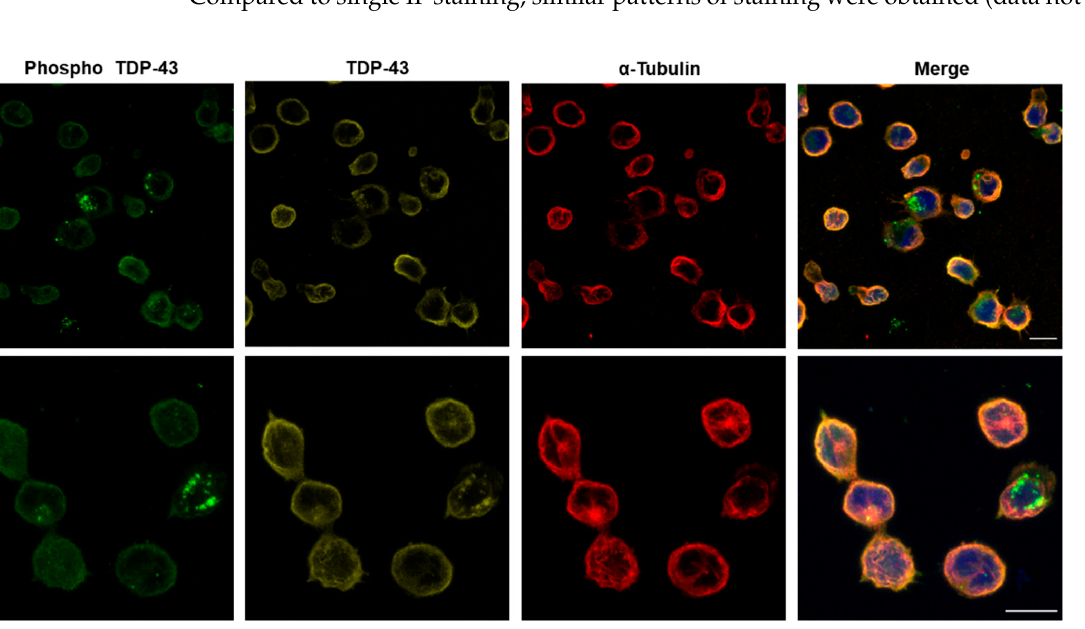
TEM. Figure S2. Electrophoretic mobility QD conjugates. Figure S3. Nuclear penetration of QDs in SH-SY5Y cells. Figure S4. QD staining with different permeabilization